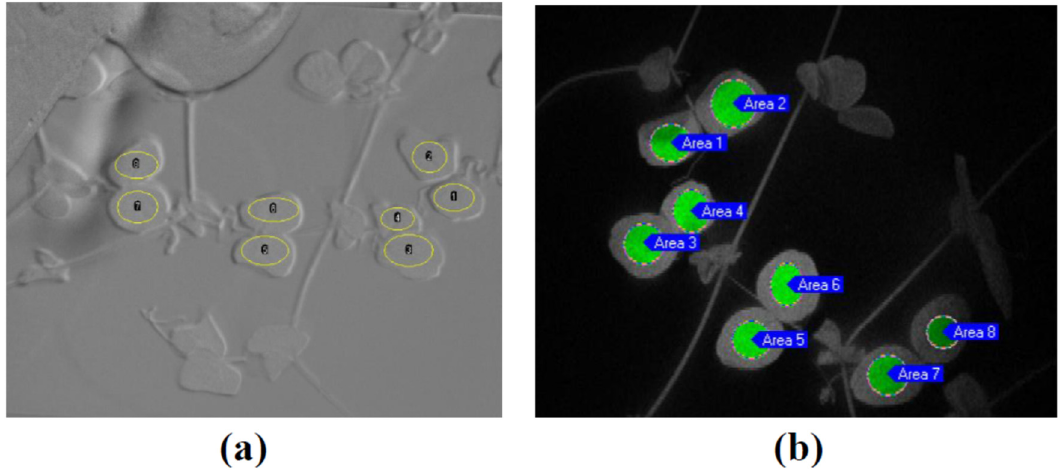
Figure 3. Example of localization of ROIs at measurement of photochemical reflectance index (PRI) ( a ) and chlorophyll fluorescence ( b ). Four pea seedlings were simultaneously measured, and two ROIs placed on pair leaflets were used for each seedling.